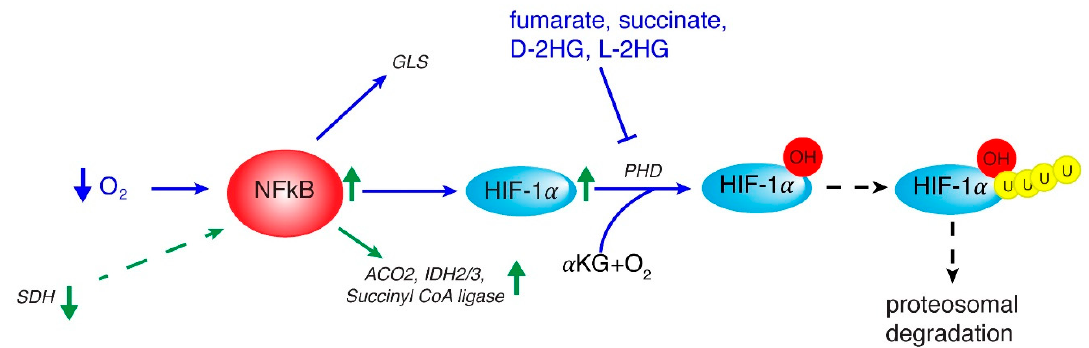
Figure 1. Interplay between NF- κ B, HIF, and mitochondrial signals. The reported important role of NF- κ B in tumor cell metabolism may originate from hypoxia that activates NF- κ B which up-regulates HIF-1 α gene. In turn NF- κ B activates glutamine metabolism via glutaminase (GLS) and TCA cycle by ACO2 (aconitase isoform 2), IDH 2 / 3 (isocitrate dehydrogenase isoform 2 and 3) and Succiyll CoA ligase genes. HIF-1 α stabilization takes place via L-2-HG, D-2-HG, succinate and fumarate which regulate PHD (oxygen-dependent prolyl hydroxylase) and subsequent HIF-1 α proteosomal degradation. Events occurring in HCC are marked by green arrows.